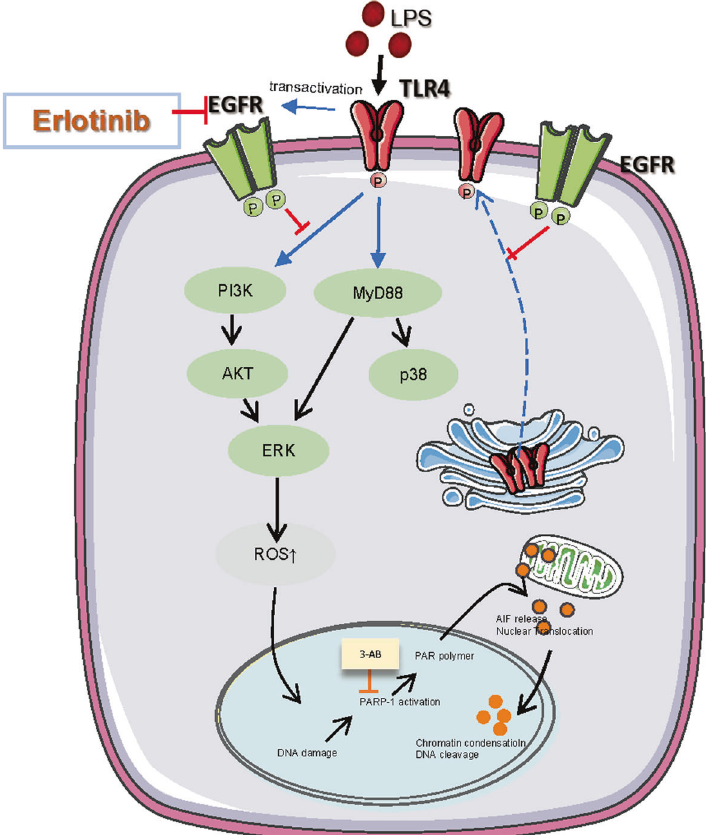
Fig. 6 The role of TLR4 in parthanatos and the MyD88 and/or the PI3K signaling pathway in parthanatos. One of the reasons that LPS- induced ROS production leads to parthanatos. Erlotinib could inhibit the cells surface TLR4 expression and alleviated the parthanatos in response to LPS. This may be through the MyD88 and/or the PI3K signaling pathway. Besides, erlotinib inhibits the generation of ROS, which in turns inhibits Reactive oxygen species measurement RAW264.7 cells or BMDM seeded at 2 × 10 5 cells/well in 6-cm petri dish were cultured and pretreated with indicated reagents. At the end of LPS (1 μ g/ml) treatment, cells were loaded with fl uorescent dye DCFH2-DA (Beyotime Biotechnology, China) in serum-free DMEM and incubated for 30 min at 37 °C in the dark. Then, cells were washed twice with PBS after suspended in fresh DMEM; the fl uorescence intensity was measured by FACScanto cytometer. Data were analyzed using FlowJo V10 (TreeStar). RNA analysis by quantitative real-time PCR Total RNA was isolated from cells using TRIzol RNA Isolation Reagents (Takara, China). PrimeScript TM RT reagent Kit with gDNA Eraser (RR047A, TaKaRa, China) was used for performing cDNA synthesis. mRNA was